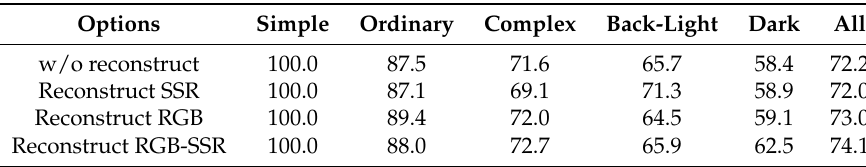
Table 4. The AP of Ours with different reconstruction options.